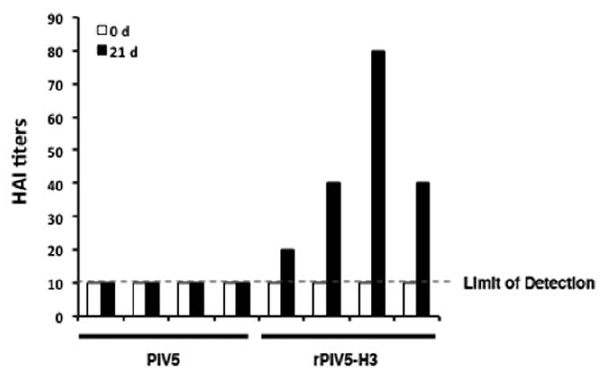
Figure 3. Immune responses in the ‘‘PIV5 naı¨ve’’ dogs in- oculated with rPIV5-H3. The dog blood samples were collected at 0 and 21 days post infection. 4 HAU of the influenza A virus (A/Udorn/ 72, H3N2 subtype) were mixed with serially diluted dog sera in 96-well round-bottom plates. The hemagglutination inhibition (HAI) titer was scored as the reciprocal of the highest dilution antiserum that completely inhibits hemagglutination. The graph shows the mean value of duplicate wells for each dog. The limit of detection of the HAI titer (10) is indicated.